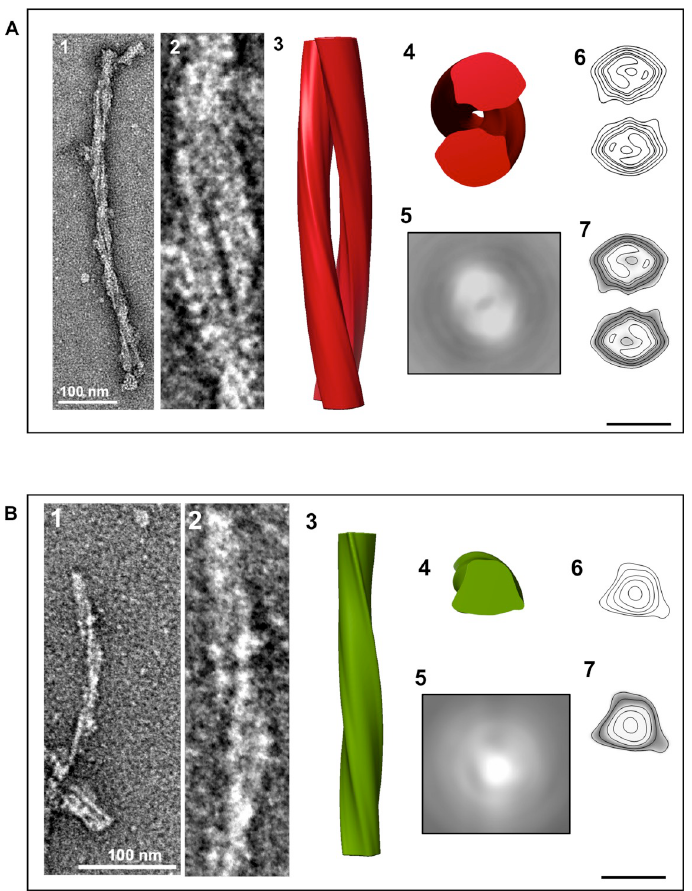
Fig 7. Three-dimensional reconstructions of L-type BSE prion fibrils. ( A ) A 3D reconstruction of a two- protofilament fibril. ( 1 ) A negatively stained electron micrograph of a L-type BSE fibril, and ( 2 ) magnified view of the selected fibril section used for generating the 3D reconstruction. ( 3 ) A surface view of the 3D reconstruction showing two intertwined helical protofilaments. ( 4 ) Cross-section of the reconstruction. ( 5 ) The corresponding 2D projection of the averaged view of the cross-section region. ( 6 ) A contour map of the cross-section. ( 7 ) A contour density plot of the cross-section obtained by superimposition of the contour map onto a cross-section from the 3D volume. ( B ) A 3D reconstruction of a one-protofilament fibril. ( 1 ) A negatively stained electron micrograph of a L-type BSE fibril, and ( 2 ) enlarged view of the selected fibril. ( 3 ) Surface view of the 3D reconstruction. ( 4 ) Cross-section of the reconstruction. ( 5 ) The corresponding 2D projection of the averaged view of the cross-section region. ( 6 ) A contour map of the cross-section. ( 7 ) A contour density plot of the cross-section. The 3D reconstructions were low-pass filtered to 20 Å resolution. Scale bar = 10